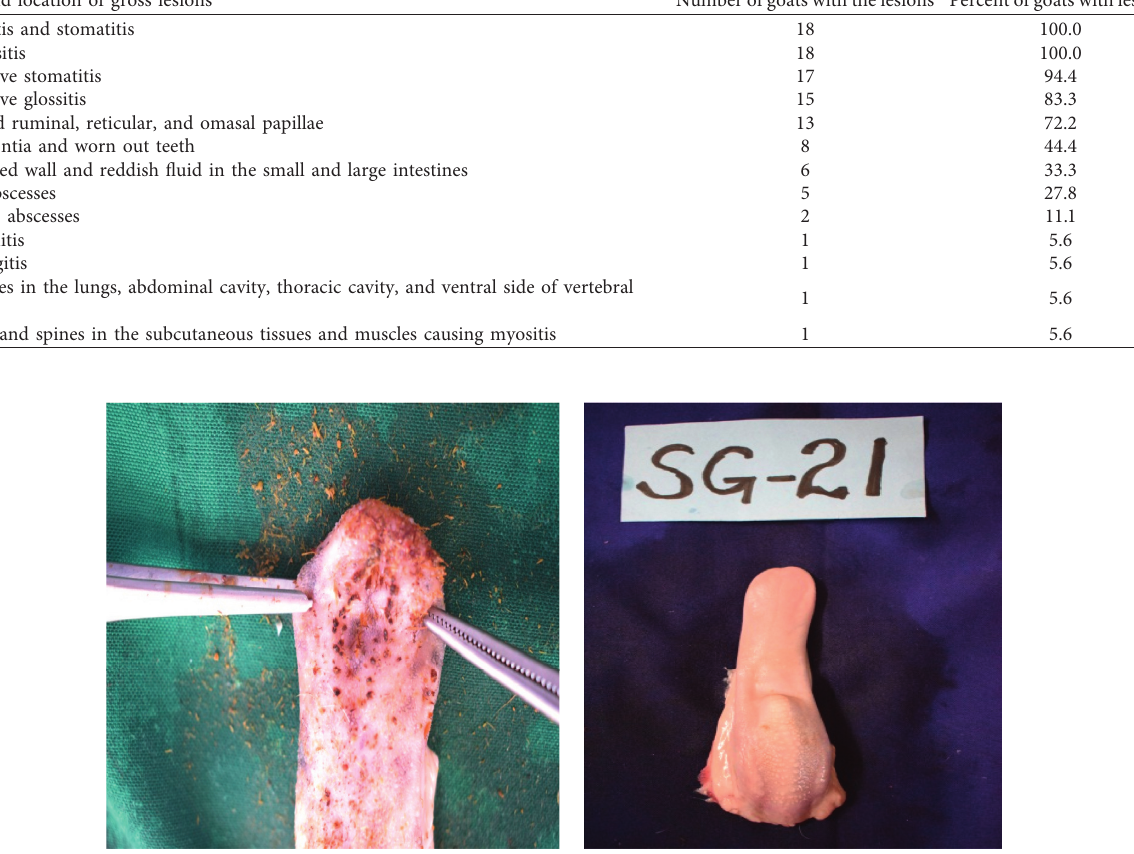
Figure 6: (a) Emaciated carcass showing atrophied musculature and body fat and the prominent vertebrae column of a goat that had consumed Opuntia stricta and (b) a fat carcass of a goat that had not consumed Opuntia stricta . Table 3: Gross lesions in the internal organs of goats that had eaten Opuntia stricta in Laikipia North sub-County. Type and location of gross lesions Number of goats with the lesions Percent of goats with lesions